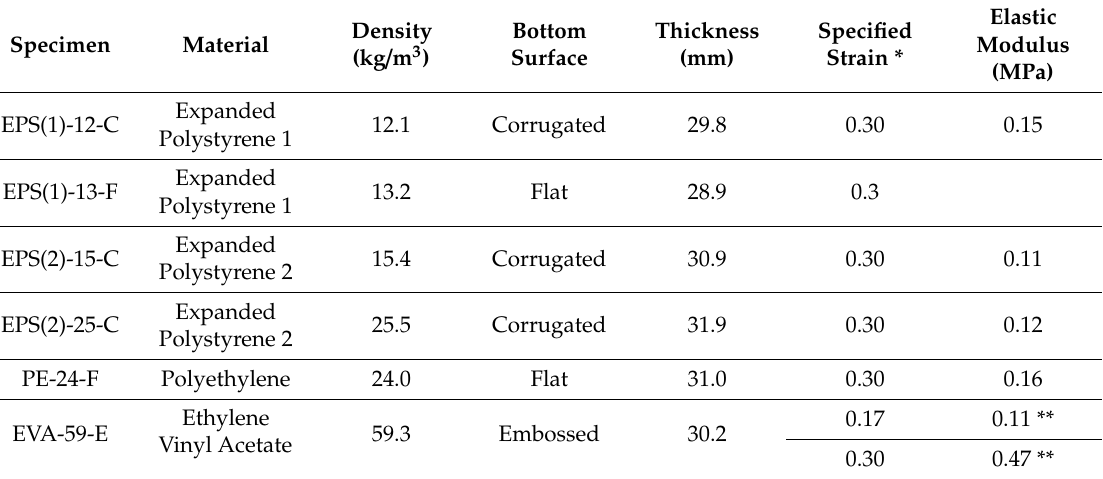
Figure 1. Bottom shape of the resilient materials. Table 1. Details of specimens.